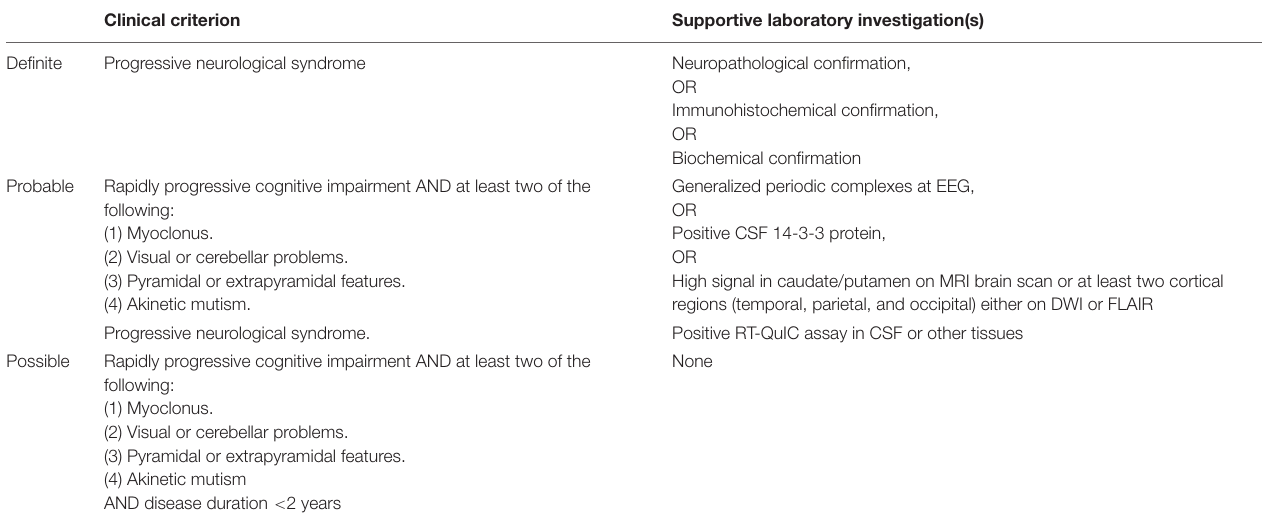
TABLE 2 | Current diagnostic criteria for surveillance of sCJD (updated January 01,